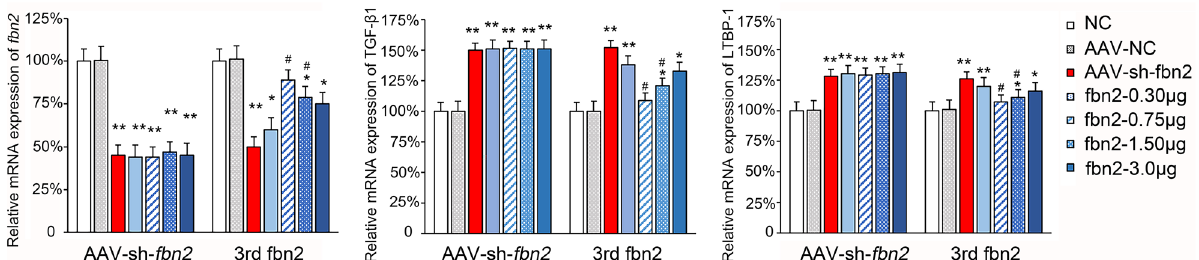
intervention. AAV-NC group: Animals with an intravitreal injection of AAV empty vector and without any further treatment. AAV-sh-fbn2 group: Animals with an intravitreal injection of AAV-sh-fbn2 and without any further treatment. Fbn2-0.30 μg group: Animals with an intravitreal injection of AAV-sh-fbn2, followed by an intravitreal injection of fbn2 recombinant protein in a dose of 0.30 μg. Fbn2-0.75 μg group: Animals with an intravitreal injection of AAV-sh-fbn2, followed by an intravitreal injection of fbn2 recombinant protein in a dose of 0.75 μg. Fbn2-1.5 μg group: Animals with an intravitreal injection of AAV-sh-fbn2, followed by an intravitreal injection of fbn2 recombinant protein in a dose of 1.50 μg. Fbn2-3.0 μg group: Animals with an intravitreal injection of AAV-sh-fbn2, followed by an intravitreal injection of fbn2 recombinant protein in a dose of 3.00